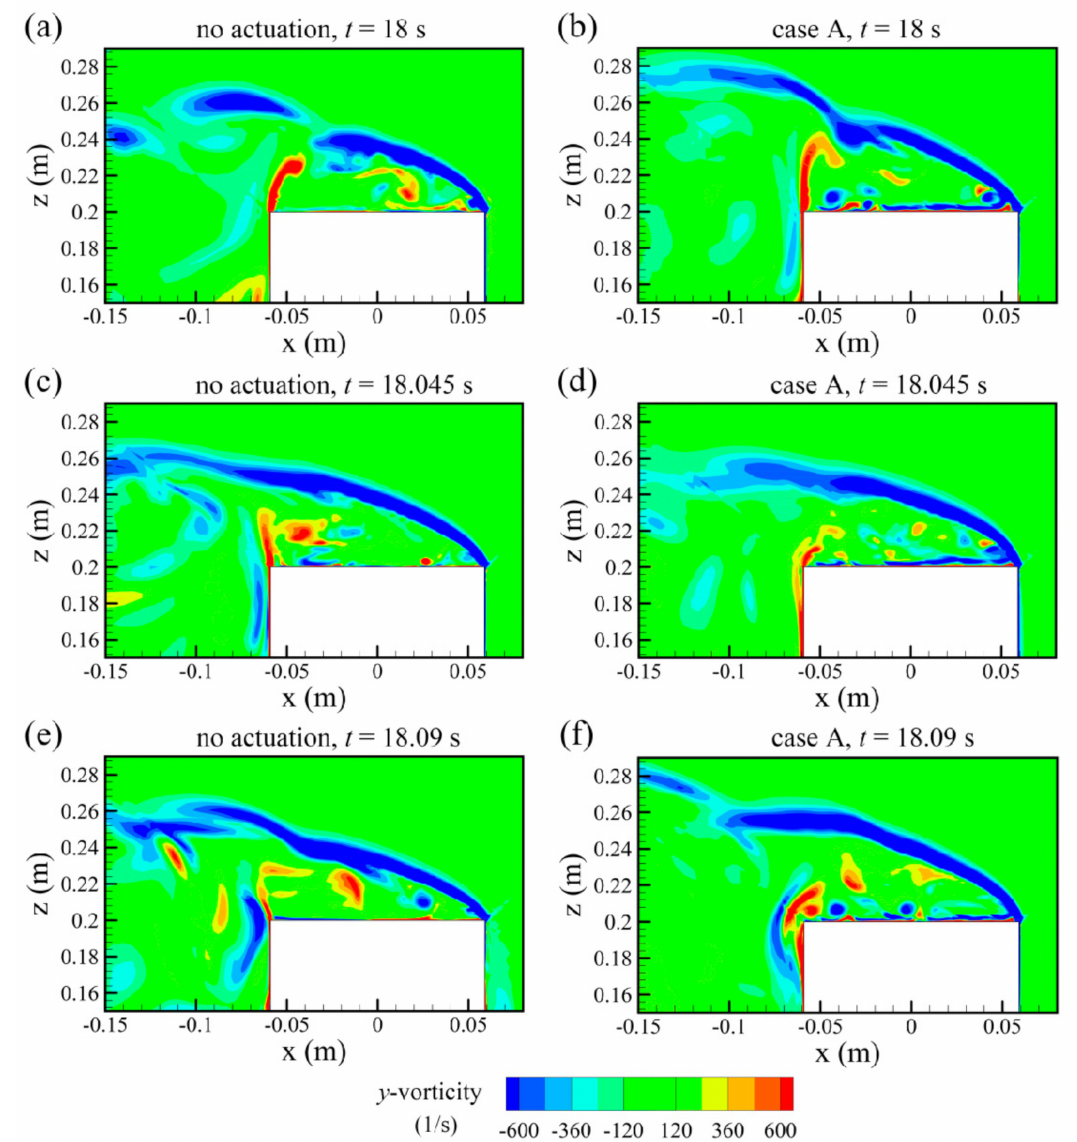
Figure 16. Evolution of instantaneous y -vorticity component with the time t : ( a , b ) t = 18 s; ( c , d ) t = 18.045 s; ( e , f ) t = 18.09